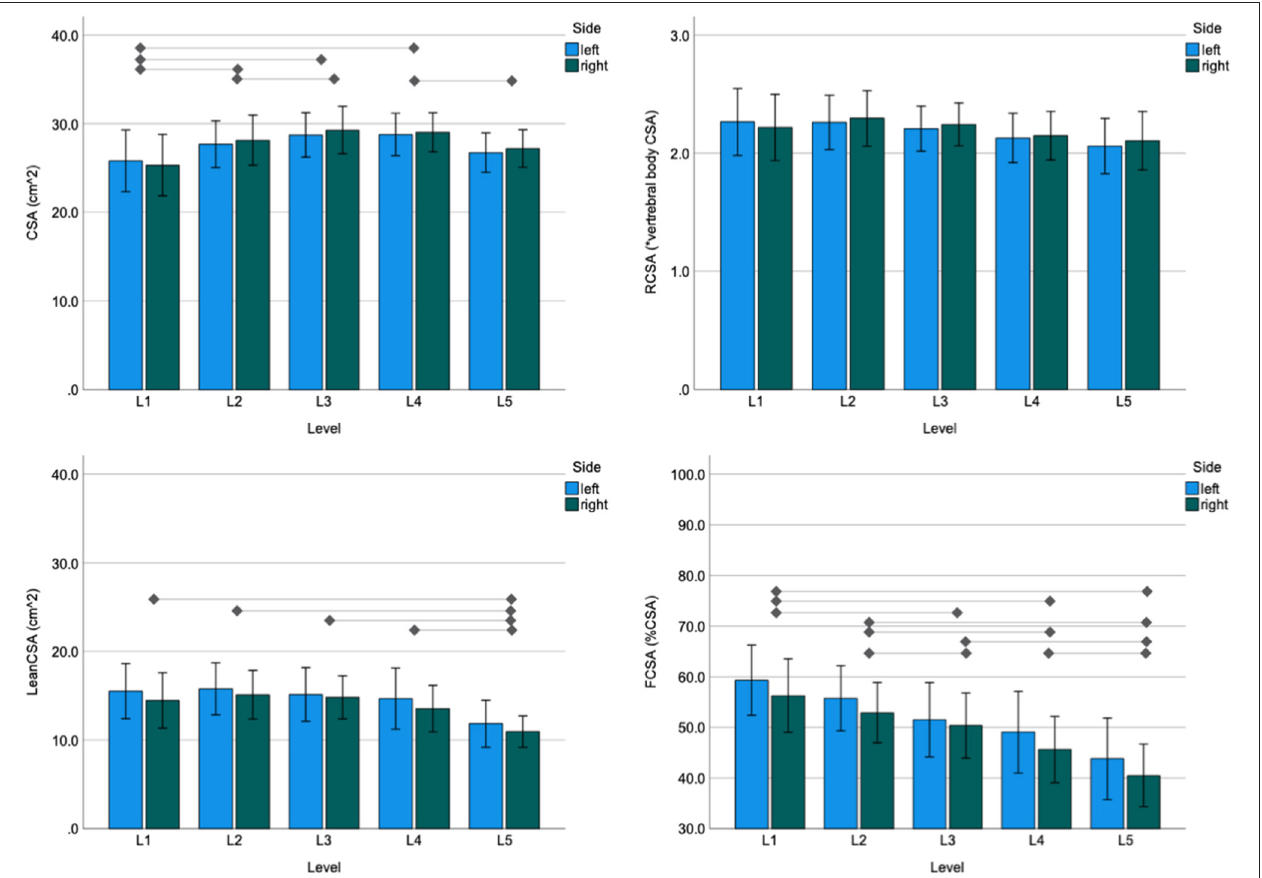
FIGURE 4 | Mean and 95% confidence interval of the paraspinal cross-sectional area (CSA; top left), relative CSA (RCSA; top right), lean muscle cross-sectional area (LeanCSA; bottom left), and the ratio of LeanCSA/CSA and CSA (LeanCSA/CSA; bottom right) for the left and right sides at each level of the lumbar spine. The horizontal lines indicate significant differences between levels. Because significant results of paired comparisons were observed for both sides for each indicated pair, horizontal bars represent differences for both sides ( t -test for paired samples, P <